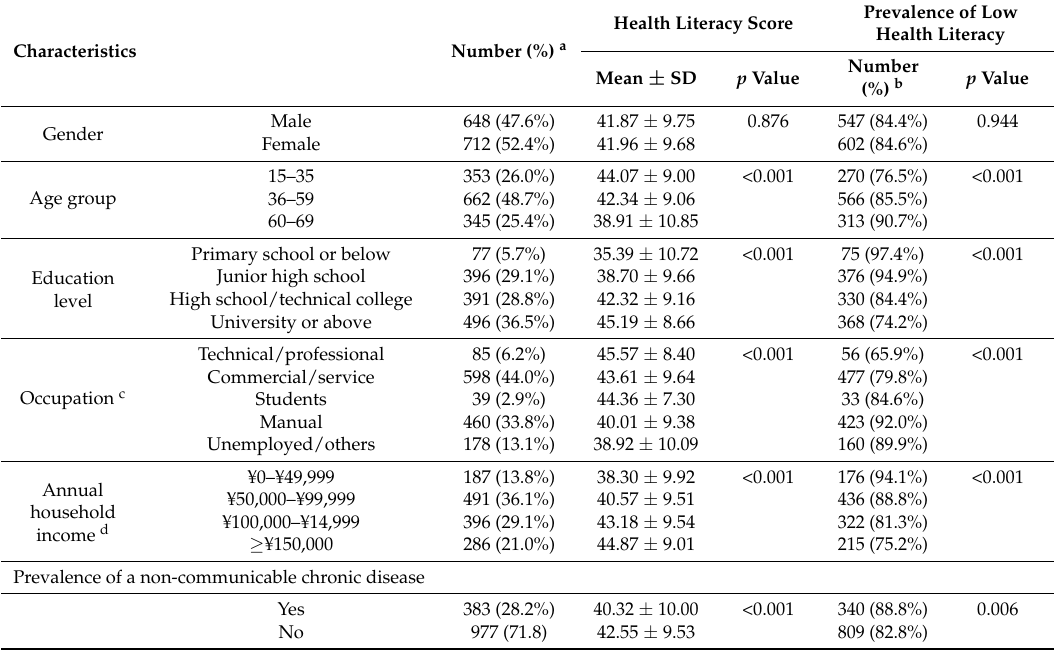
Table 2. Health literacy score and the prevalence of low health literacy by participant characteristics.